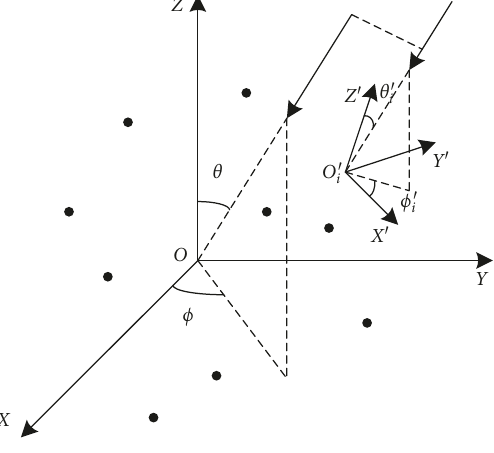
Figure 1: Conformal array coordinate